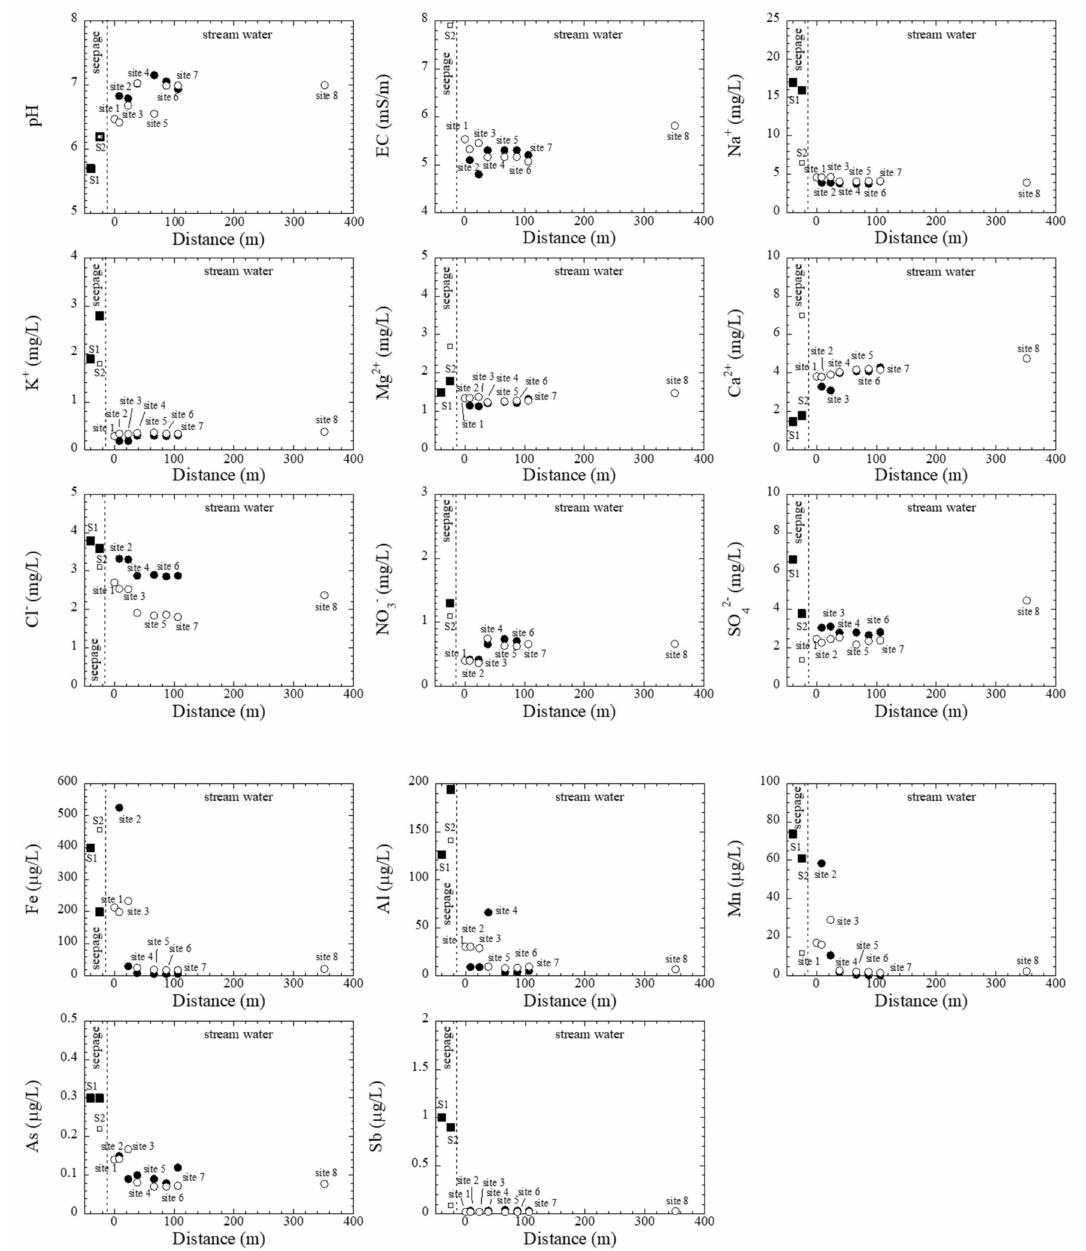
Figure 6. pH, electric conductivity (EC), and individual solute concentration in the samples of seepage and stream waters collected from each site. The square symbols represent seepage water and the circle symbols represent stream water. Closed symbols represent samples from March 2007 and open symbols represent symbols from December